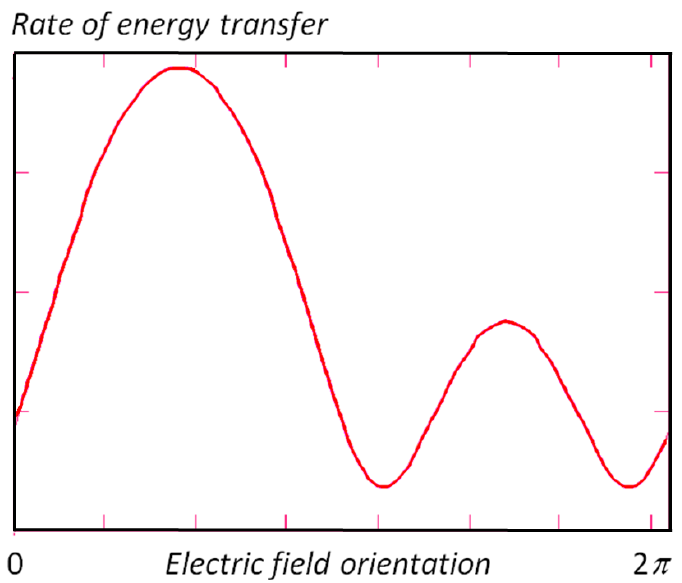
Figure 5. Influence on the rate of energy transfer (arbitrary scale) of a static field, as the polarisation vector of the static field is varied relative to the transfer pair. Here, the donor and acceptor transition moments are assumed to be equal in magnitude (10 − 29 C m) and to have a parallel disposition; the static field strength is 10 10 V m − 1